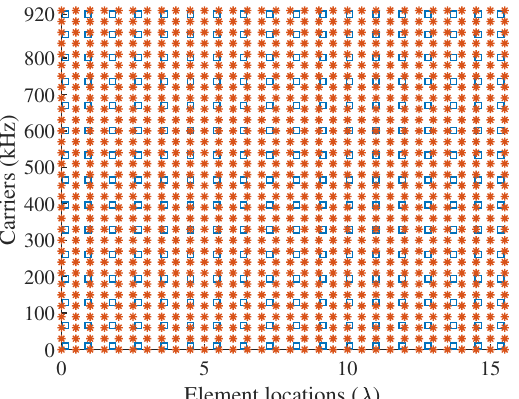
Figure 5. The comparsion of layout between the uniform MCFDA (red asterisk) and obtained sparse MCFDA (blue square box).